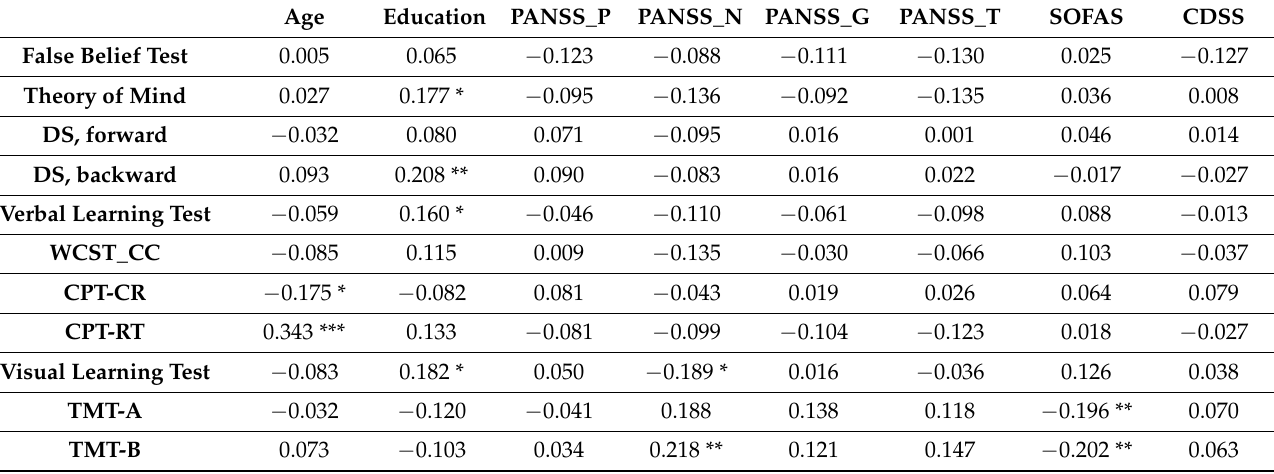
Table 1. Spearman correlation coefficients between cognitive measures and clinical